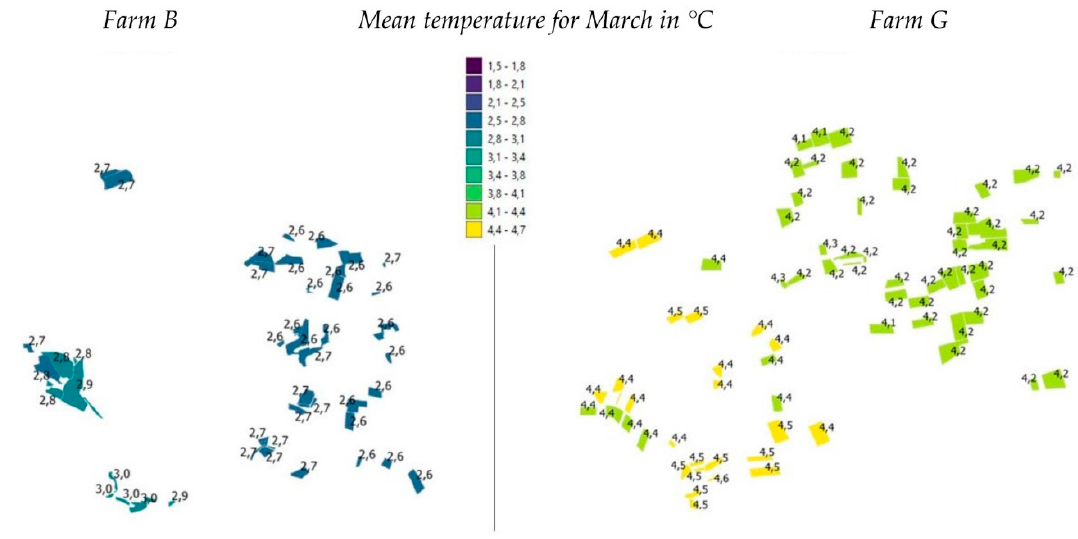
Figure A1. Climate map for March for fields of model farms B and